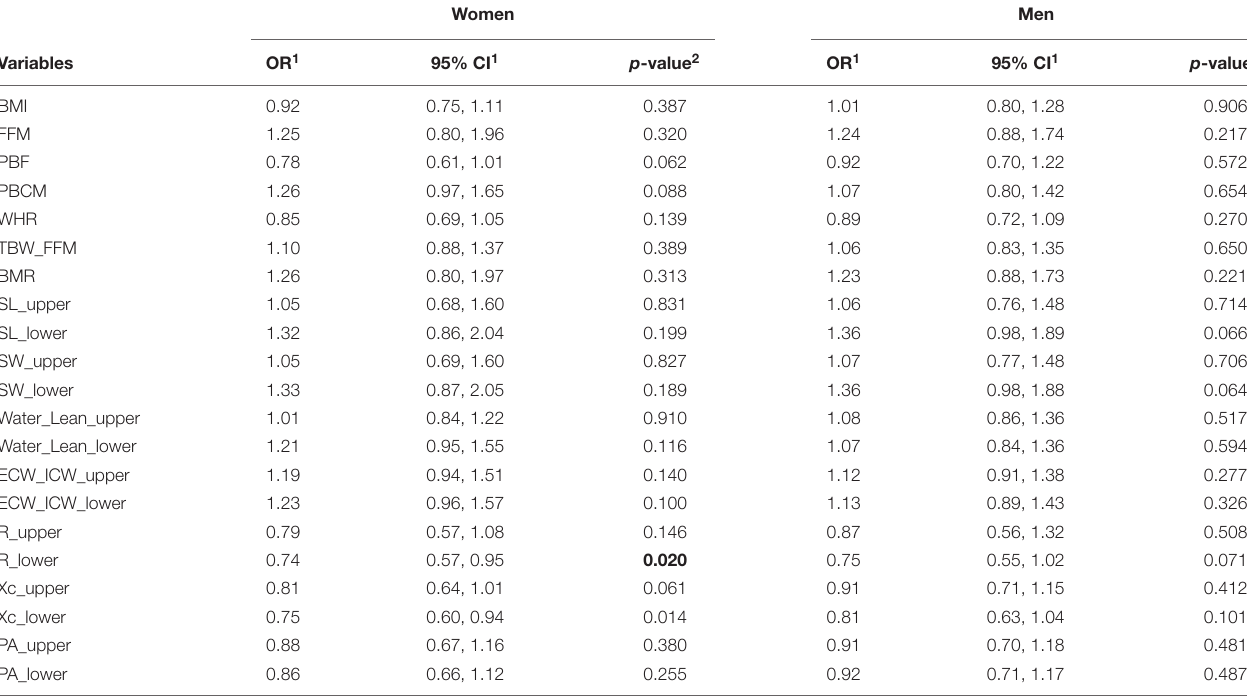
TABLE 4 | Estimated odds ratios and 95% confidence intervals derived from the logistic regression models in women and men. Women